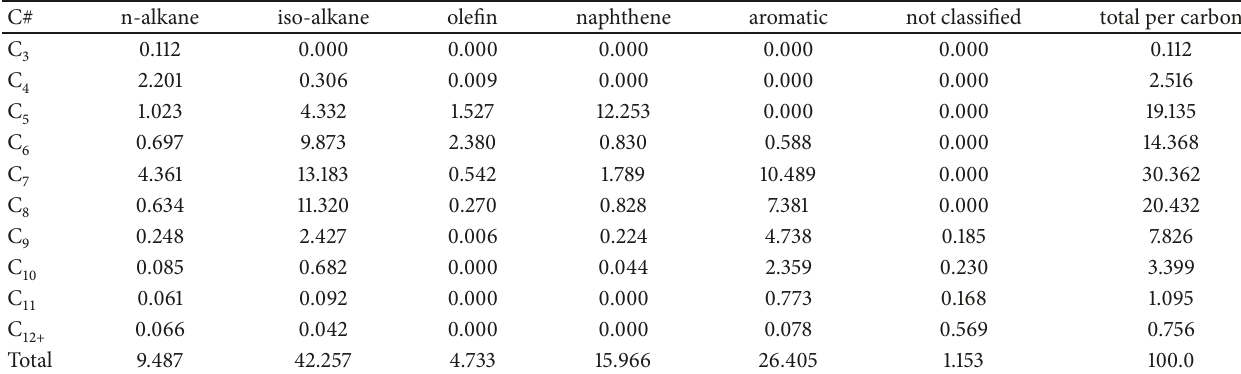
Table 1: Gasoline Research and Development(RD387) mixture composition by using gas chromatography(GC). Data are in volume fraction.